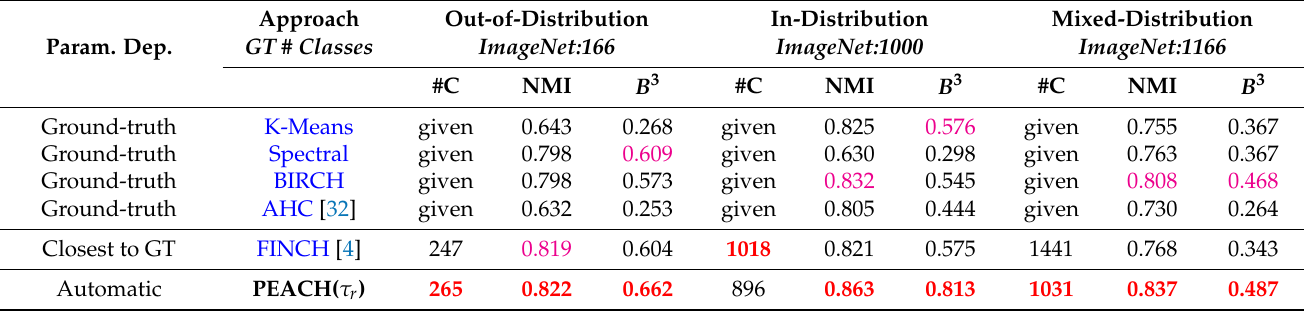
Table 2. Clustering for Out/In/Mix Distribution ImageNet data. This table shows NMI and B 3 F-scores on ImageNet 2010 and 2012 validation sets with 166 (Out-of-Distribution data), 1000 (In-Distribution data), and 1166 classes (Mixed-Distribution data). We mark the second-best and best results , as well as algorithms that optimize parameters on the test set.